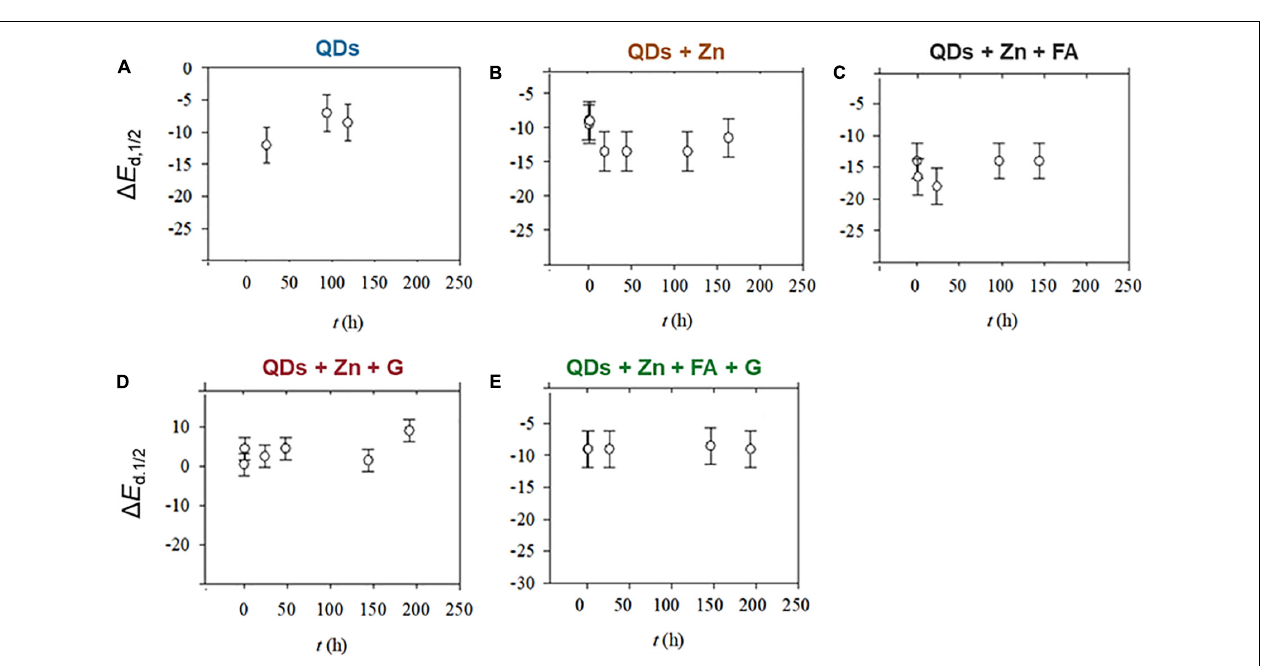
FA (condition C), | (cid:49) E d , 1 / 2 | values are slightly higher than